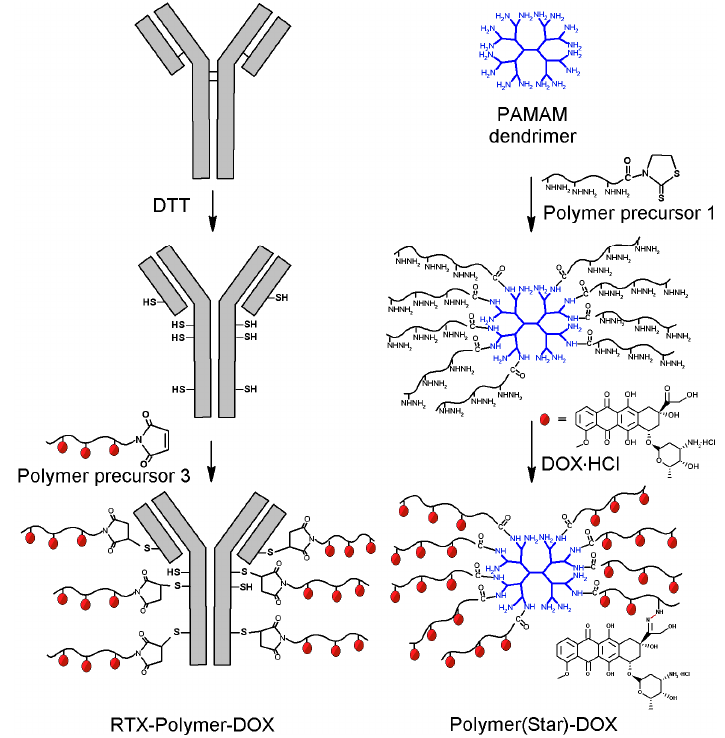
Figure 2. Schematic description of synthesis of star-like polymer-DOX conjugates: left —preparation